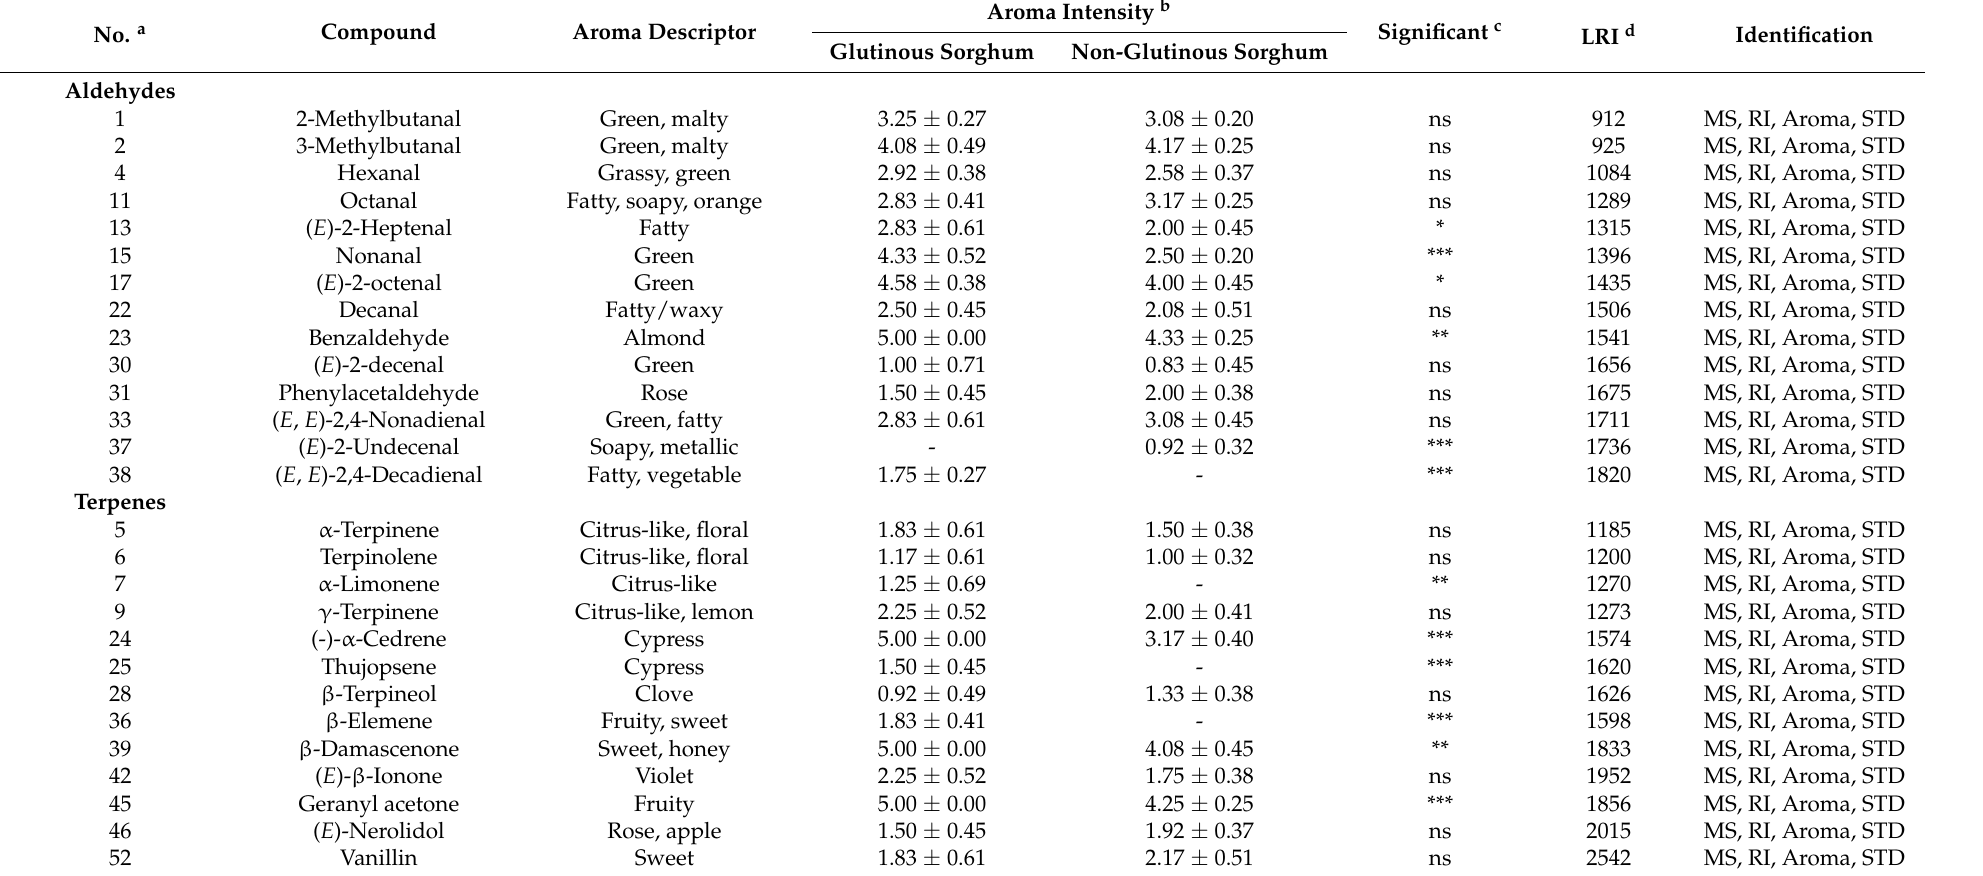
Table 3. Aroma compounds in cooked glutinous and non-glutinous